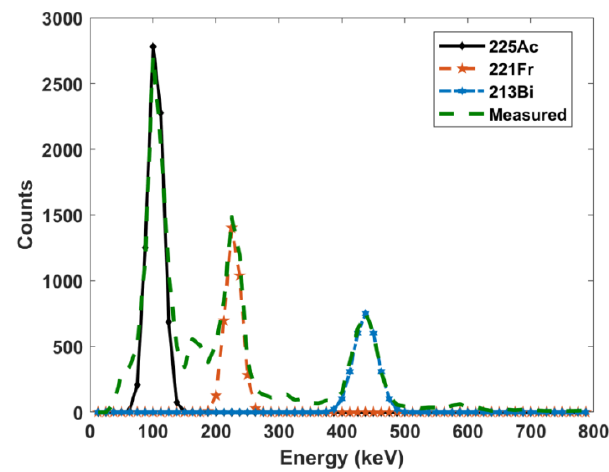
Figure 4. NaI(Tl) measured gamma spectrum with Gaussian fitting. Table 1. Ion chamber and NaI(Tl) measured activities. Single measurements were taken in each detector. Notice that as the ion chamber readings increase, the discrepancies with the NaI(Tl) increase.